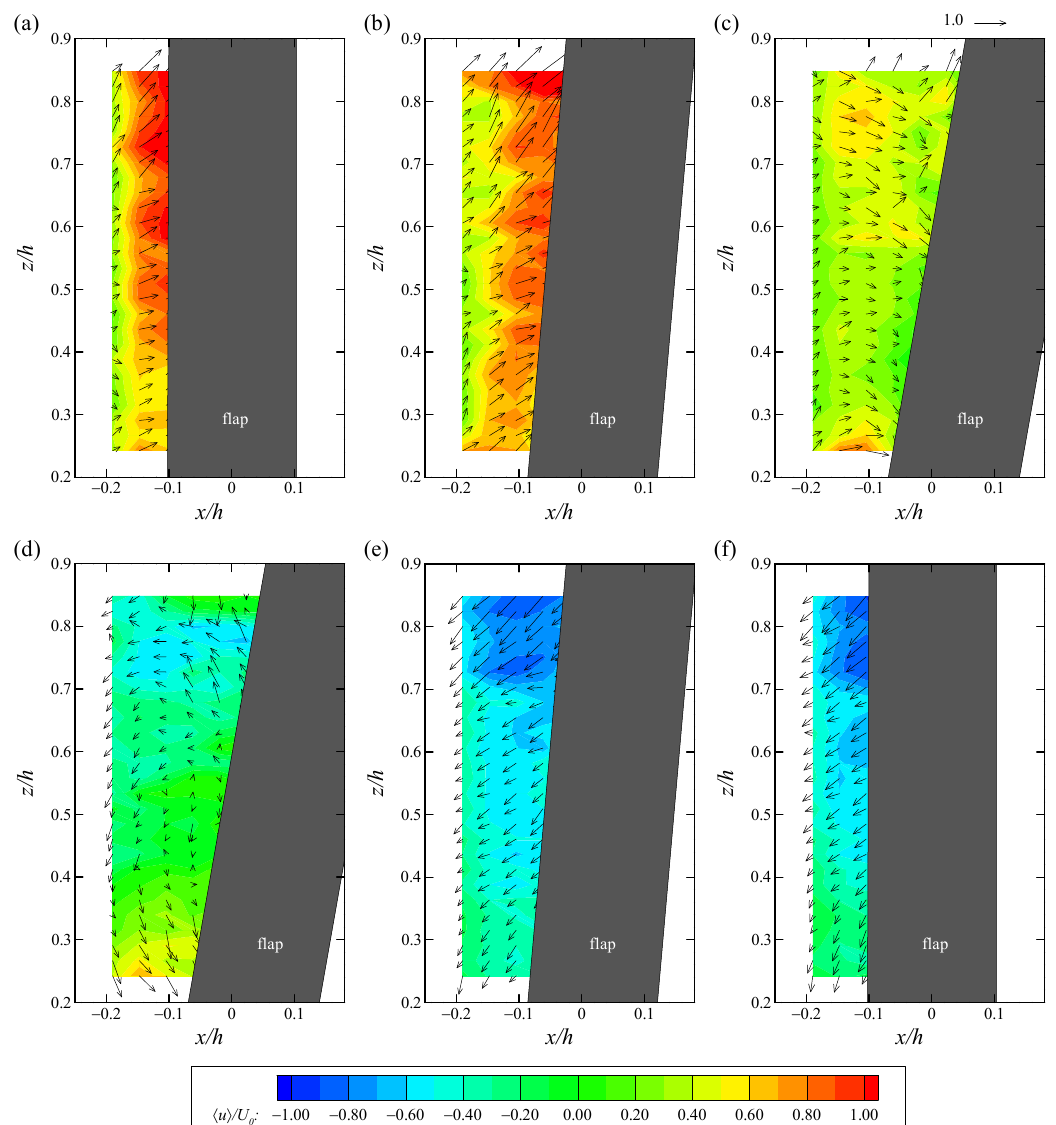
Figure 11. Experimental phase-averaged velocity vector field and contour of longitudinal velocity normalized by U 0 at ( a ) t / T = 0, ( b ) t / T = 0.06, ( c ) t / T = 0.15, ( d ) t / T = 0.27, ( e ) t / T = 0.38, and ( f ) t / T =